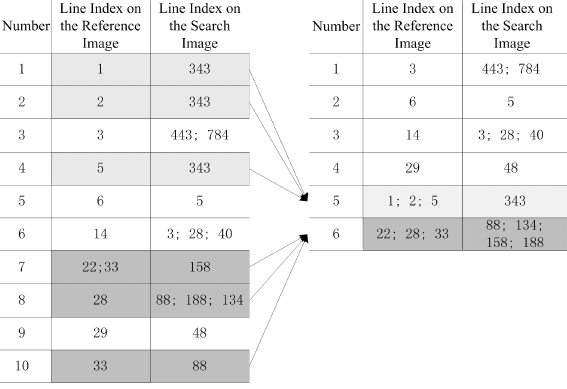
Fig.3 Vertical distance and overlap distance between lines